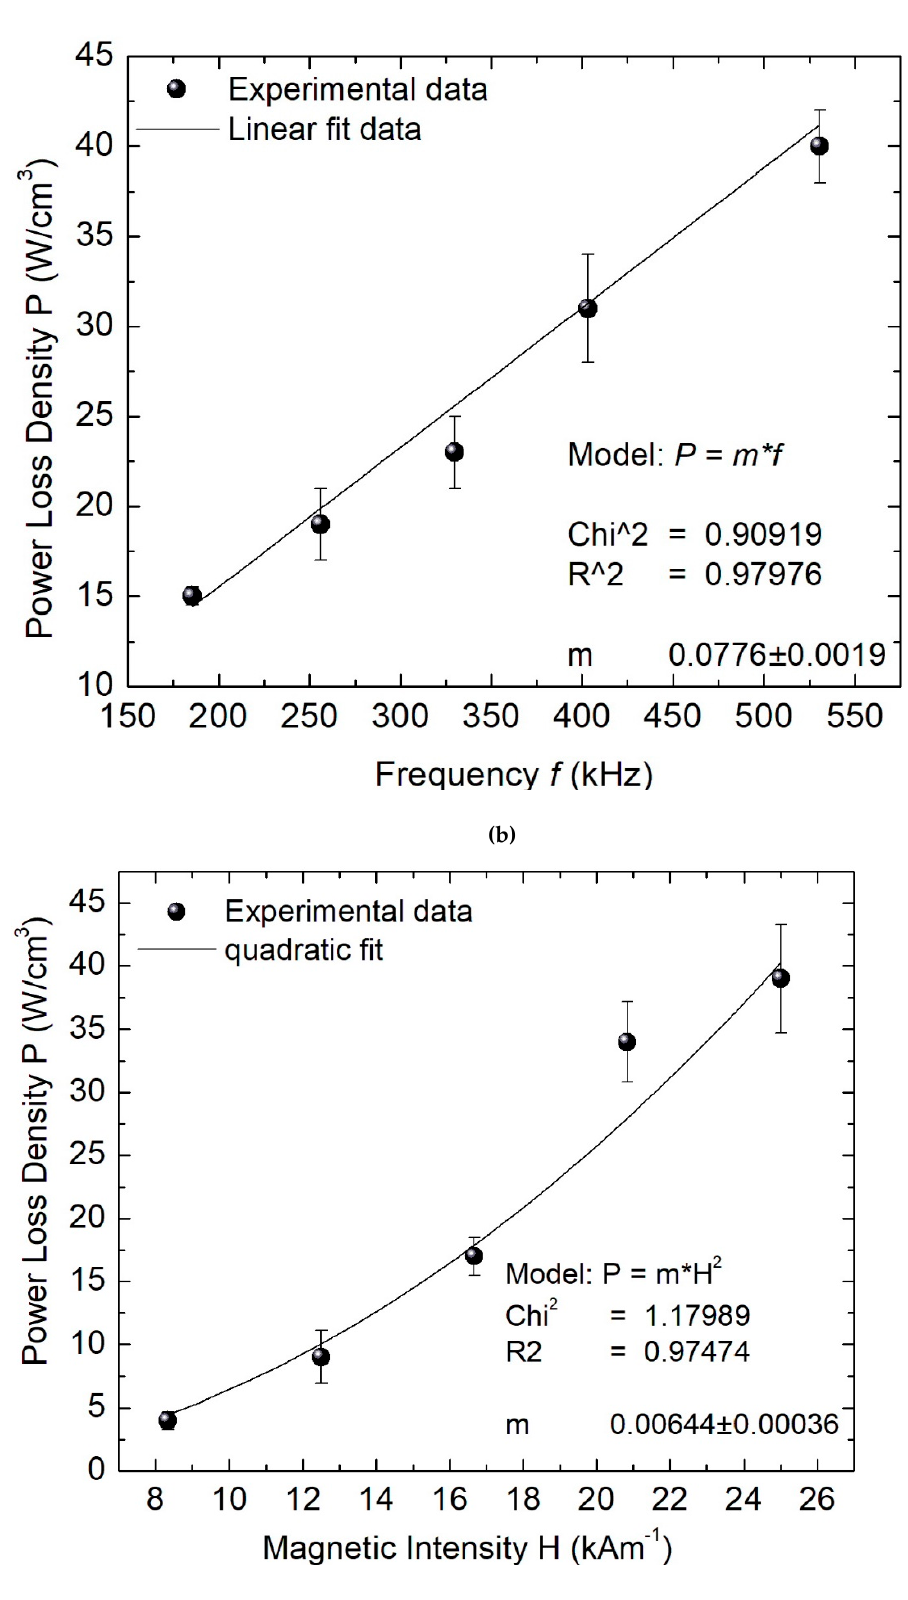
Figure 5. Dependences of: ( a ) T vs . t for several values f ; ( b ) P vs. f including a linear fit to experimental data; and ( c ) P vs. H including a quadratic fit to experimental data.